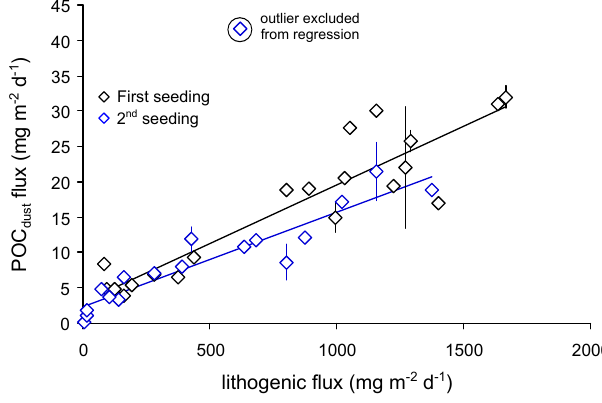
Fig. 6. POC dust versus lithogenic fluxes. Solid lines represent linear regressions with the following slopes, intercepts, determi- nation coefficients, and probabilities (Fisher test). First seeding: N = 21, slope=0.016 ± 0.002, intercept=3.11 ± 1.48, R 2 = 0 . 85, p < 0 . 0001. Second seeding: N = 17, slope=0.013 ± 0.001, inter- cept=2.41 ± 0.80, R 2 = 0 . 88, p < 0 . 0001. The highlighted outlier was excluded from the linear regression for second seeding data. Uncertainties correspond to the standard deviation of one sample measured two